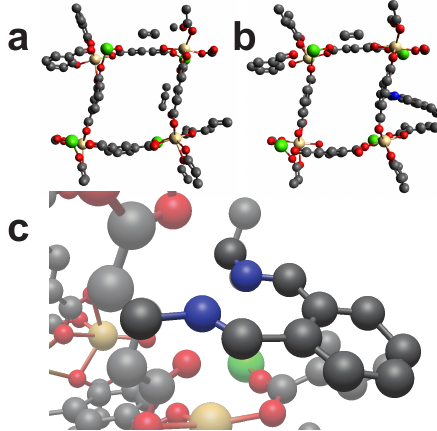
Figure 5. The MOF “EKOPEA” can be cross-linked by using cross-linker CL1. ( a ): Unmodified view of EKOPEA. ( b ): EKOPEA with cross-linker attached. ( c ): Zoomed view of cross-linking. Color code: Black (C), Blue (N), Red (O), Green(Ca), Gold (Cd). Hydrogens omitted for